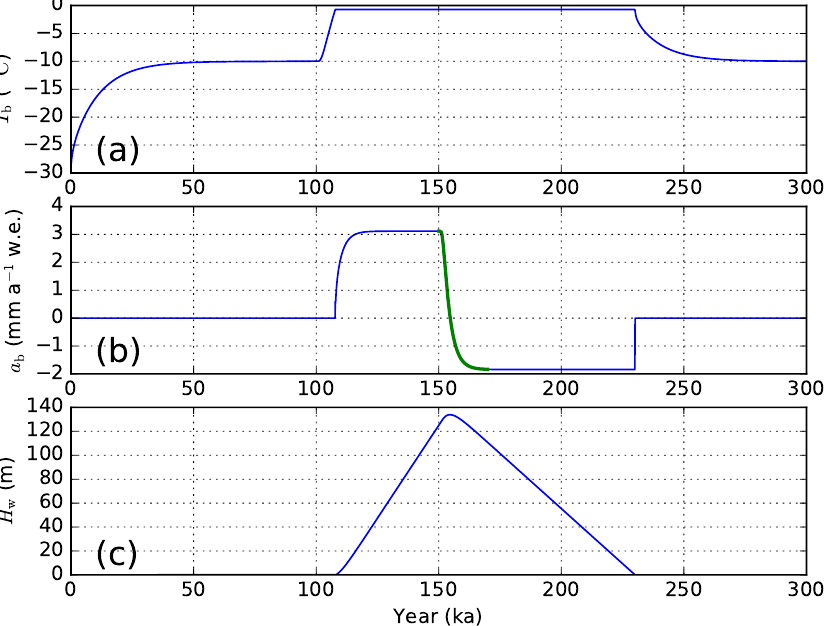
Figure 8. The result of (a) basal temperature ( T b ), (b) basal melt rate ( a b ), and (c) basal water thickness ( H w ) for enthalpy benchmark experiment A. The green line from 150 to 170ka in (b) indicates the analytical results (overlapped with model